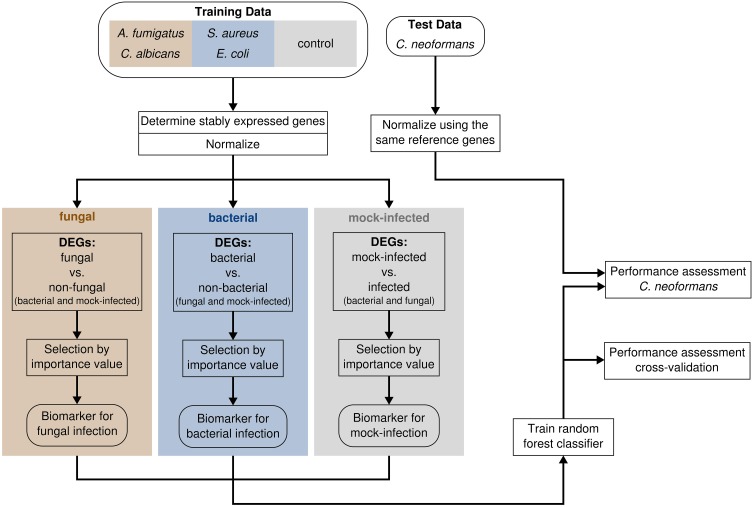
The workflow for biomarker identification, classifier construction and performance assessment.